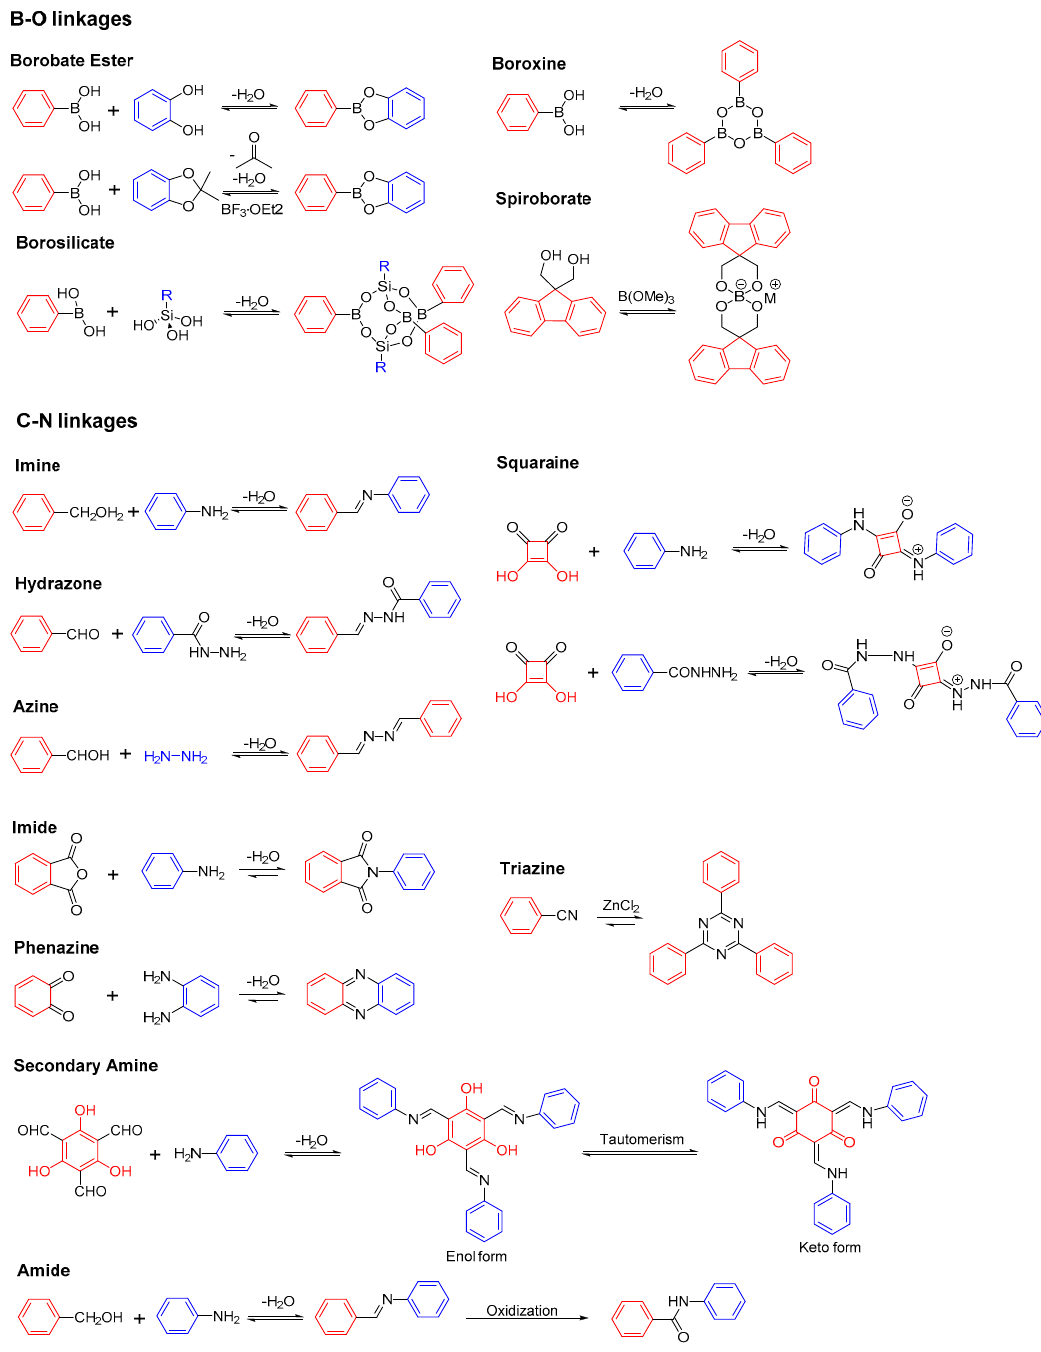
Figure 1. Several reversible reactions used for construction of COF materials. Dynamic reversible reactions are essential for the formation of crystal covalent organic frameworks (COFs). These reversible reactions for the formation of COFs are boron-containing linkages (for example, boroxine, boronate ester, borazine and spirobrate), nitrogen-containing linkages (for example, imine, hydrazone, azine, squaraine, phenazine, triazine, imide and azodioxy), and a double-stage linkage containing the boronate ester linkage and the imine linkage in one COF via a one-pot reaction.